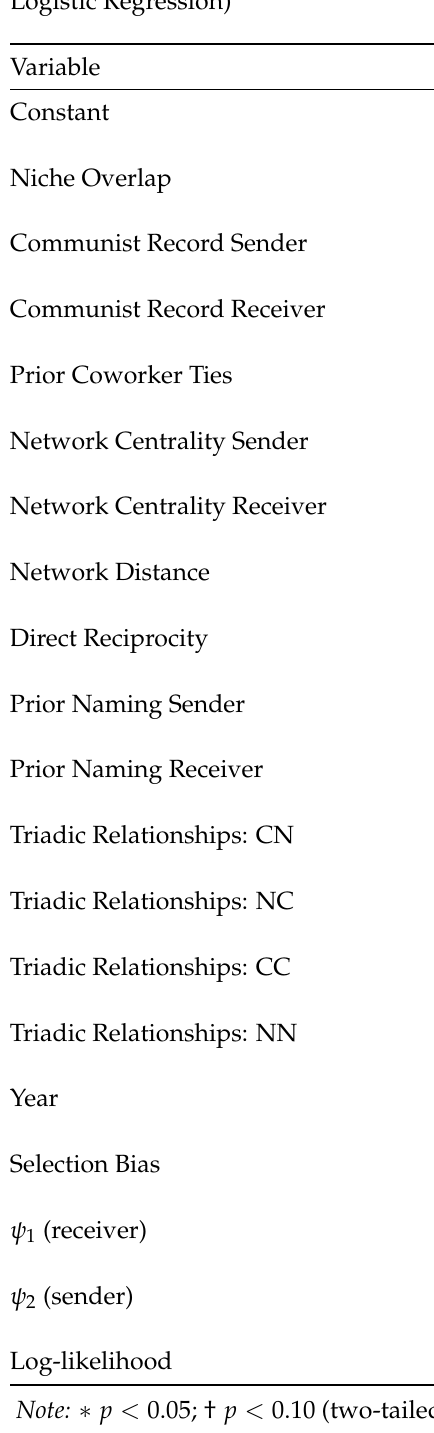
Table 3: Maximum-Likelihood Estimates of Informing during the HUAC Hearings (Cross